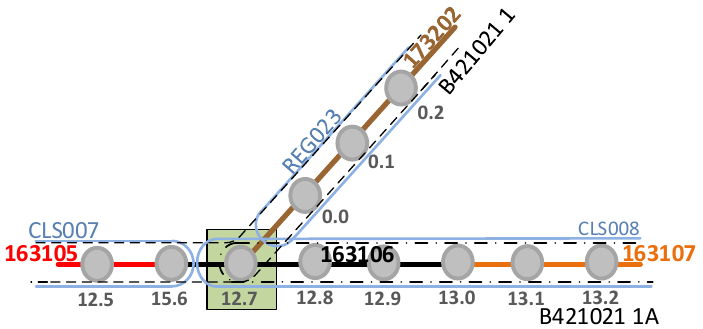
Figure 2. Methodology of railway network description.